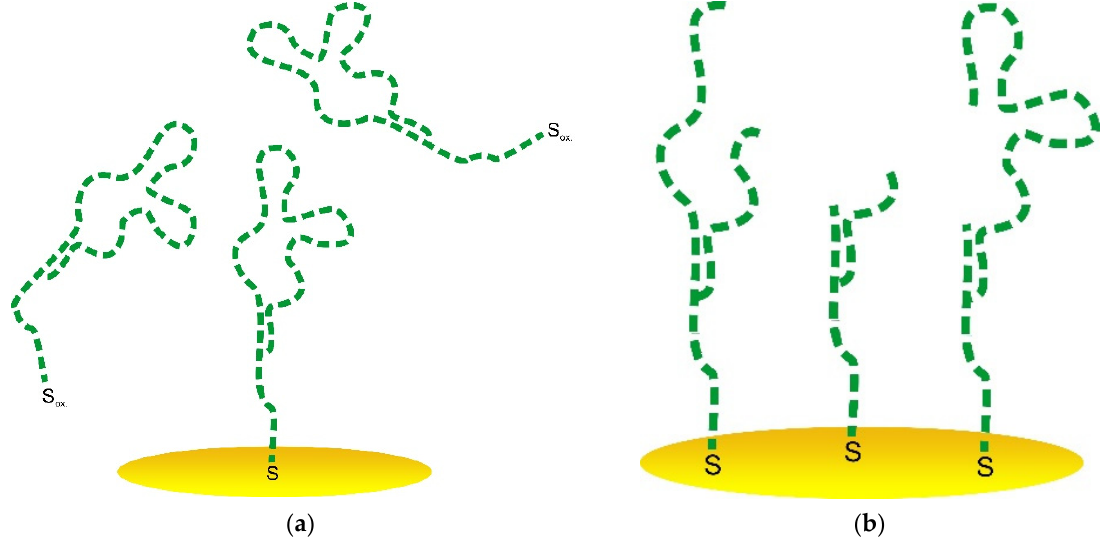
Figure 7. Schematic representation of the aptasensor surface with the partially desorbed aptamer ( a ) and partially decom- posed aptamer ( b ).